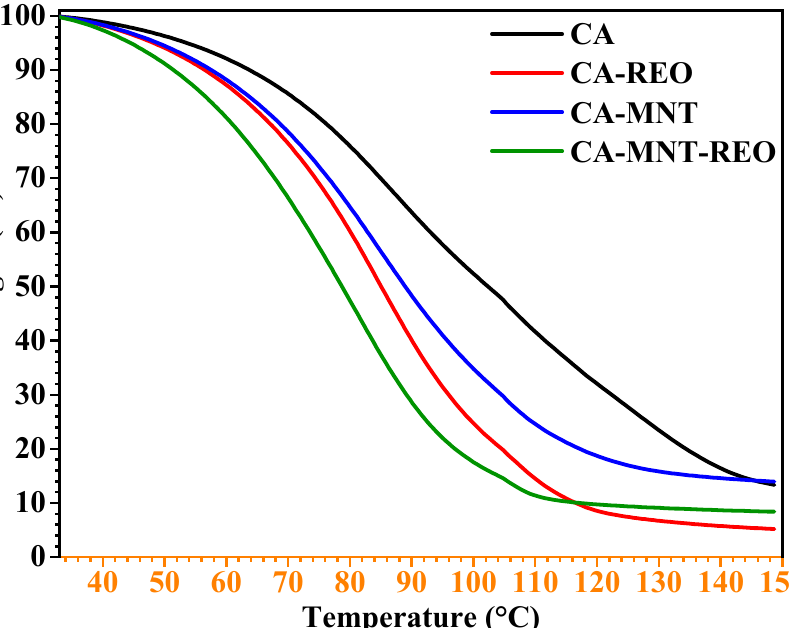
Figure 3. TGA curves of calcium alginate (CA), calcium alginate-montmorillonite (CA-MTN), calcium alginate-rosemary essential oil (CA-REO), and calcium-alginate-montmorillonite-rosemary essential oil (CA-MTN-REO) microcapsules.